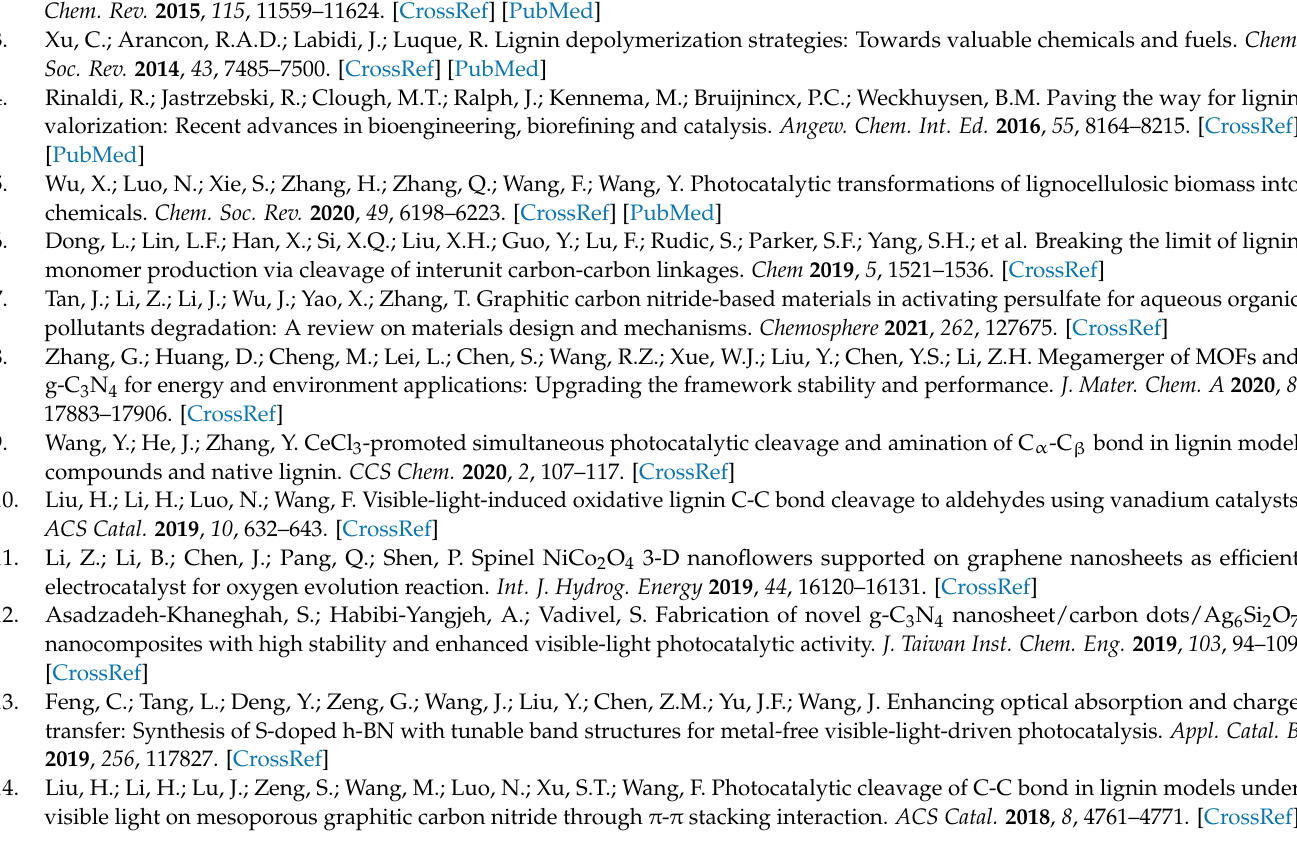
shell [33]. Figure S3. Conversion and product yield of photocatalytic conversion ML of tri-s-tri- C 3 N 4 in different organic solvents. Figure S4. Recycles experiment of tri-s-tri-C 3 N 4 . Figure S5. Photocatalytic reaction results of lignin model compound with different structures. Table S1. The fluorescence attenuation components of fitted g-C 3 N 4 , tri-C 3 N 4 and tri-s-tri-C 3 N 4 . References [15,33] are cited in the supplementary